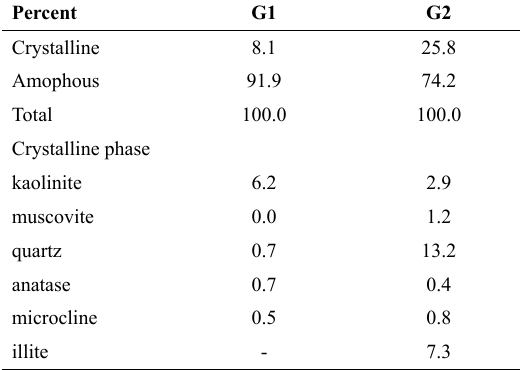
Table 5. Molar ratios adopted for designing the geopolymer matrices. Mixture